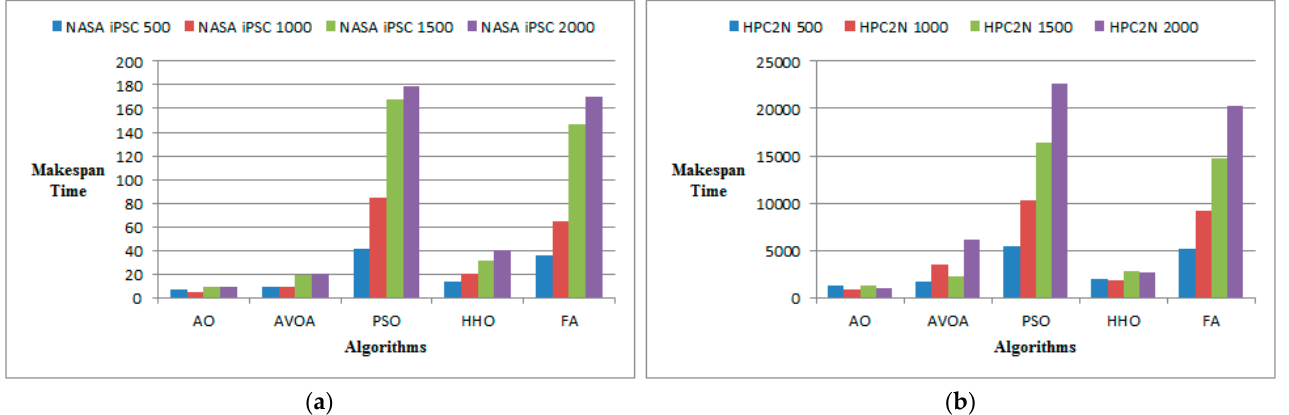
Figure 3. Diagram of the di ff erence in makespan time for AO_AVOA with AO, AVOA, PSO, HHO, and FA for both datasets. ( a ) NASA iPSC dataset. ( b ) HPC2N dataset.